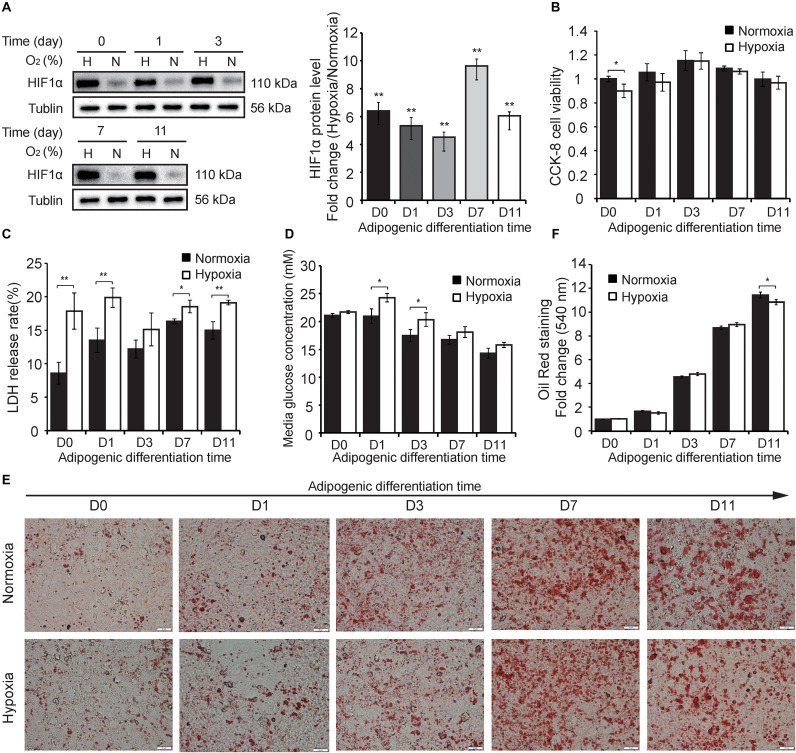
Hypoxic responses of cells during adipogenesis. (A) Western blot analyses of HIF-1α protein (left panel). Band intensities were quantified using ImageJ software (right panel) and Tubulin was used as a control. Cell viability (B), membrane damage (C), and the medium glucose concentration (D) were evaluated in cells at different stages of adipogenesis under hypoxia (1% O2) and normoxia (21% O2). (E) The cells at different stages of adipogenesis were stained by ORO and were photographed (scale bar: 20 μm). (F) Triglyceride in stained cells were quantified by measuring the absorbance at 510 nm. Three independent experiments were performed in triplicate. Means ± SD are presented for each group. *p < 0.05, **p < 0.01; hypoxia group compared with the normoxia-matched group at each timepoint. H, hypoxia; N, normoxia.